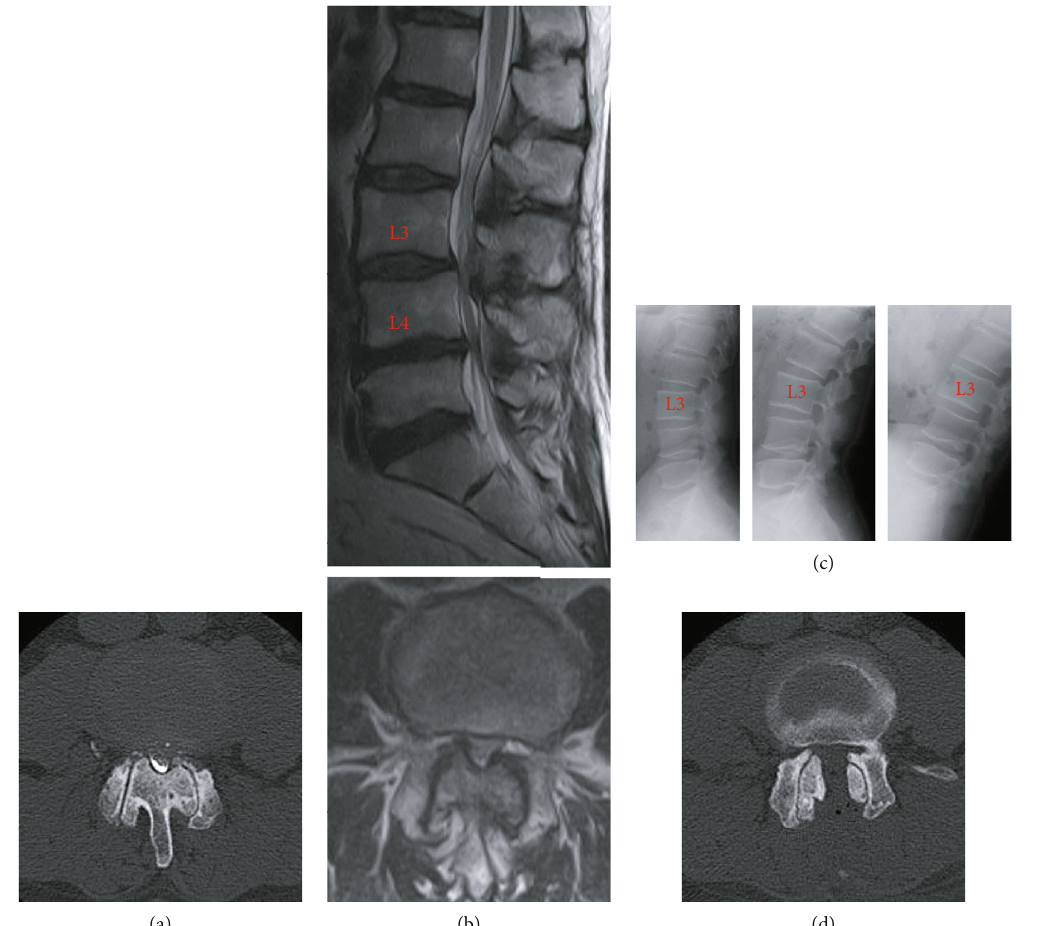
Figure 2: Radiographic images before and after the second surgery. (a) Computed tomography (CT) myelogram before the second surgery showing restenosis due to marked bone overgrowth of the lamina and facet joints. (b) Magnetic resonance (MR) image before the second surgery showing lumbar canal stenosis at L3/L4. (c) Dynamic X-ray images (neutral, extension, and fl exion position) before the second surgery showing no signi fi cant changes in lumbar alignment or spinal stability. (d) CT image 4 days after the second surgery showing the results of the bilateral laminectomy at